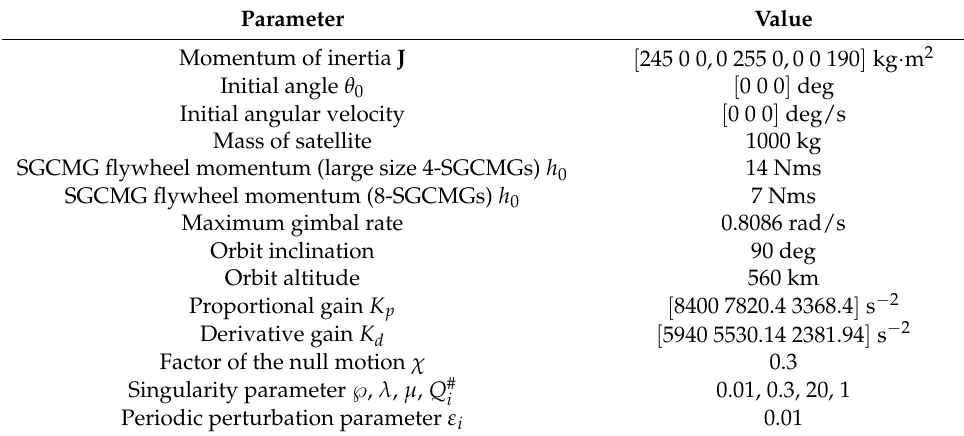
Table 7. Simulation